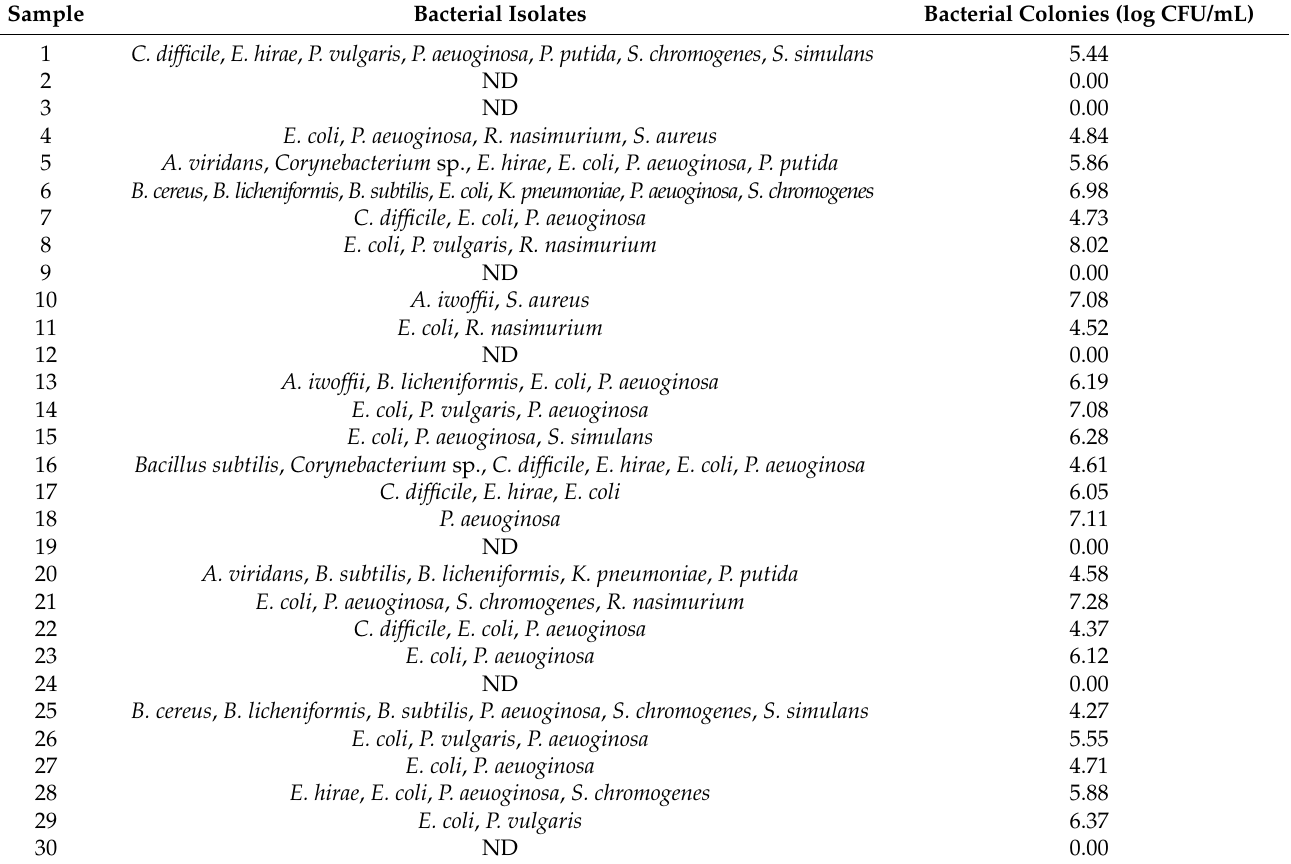
Table 8. Bacterial profiles of boar semen samples used in the